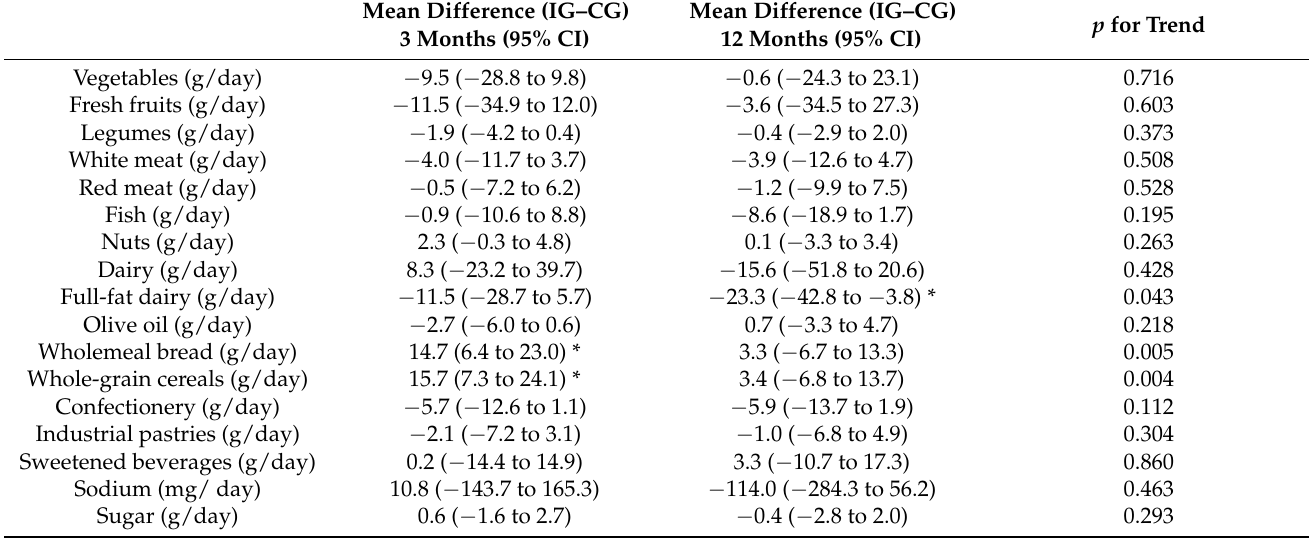
Table 5. Effect of the intervention on the intake of food groups throughout the